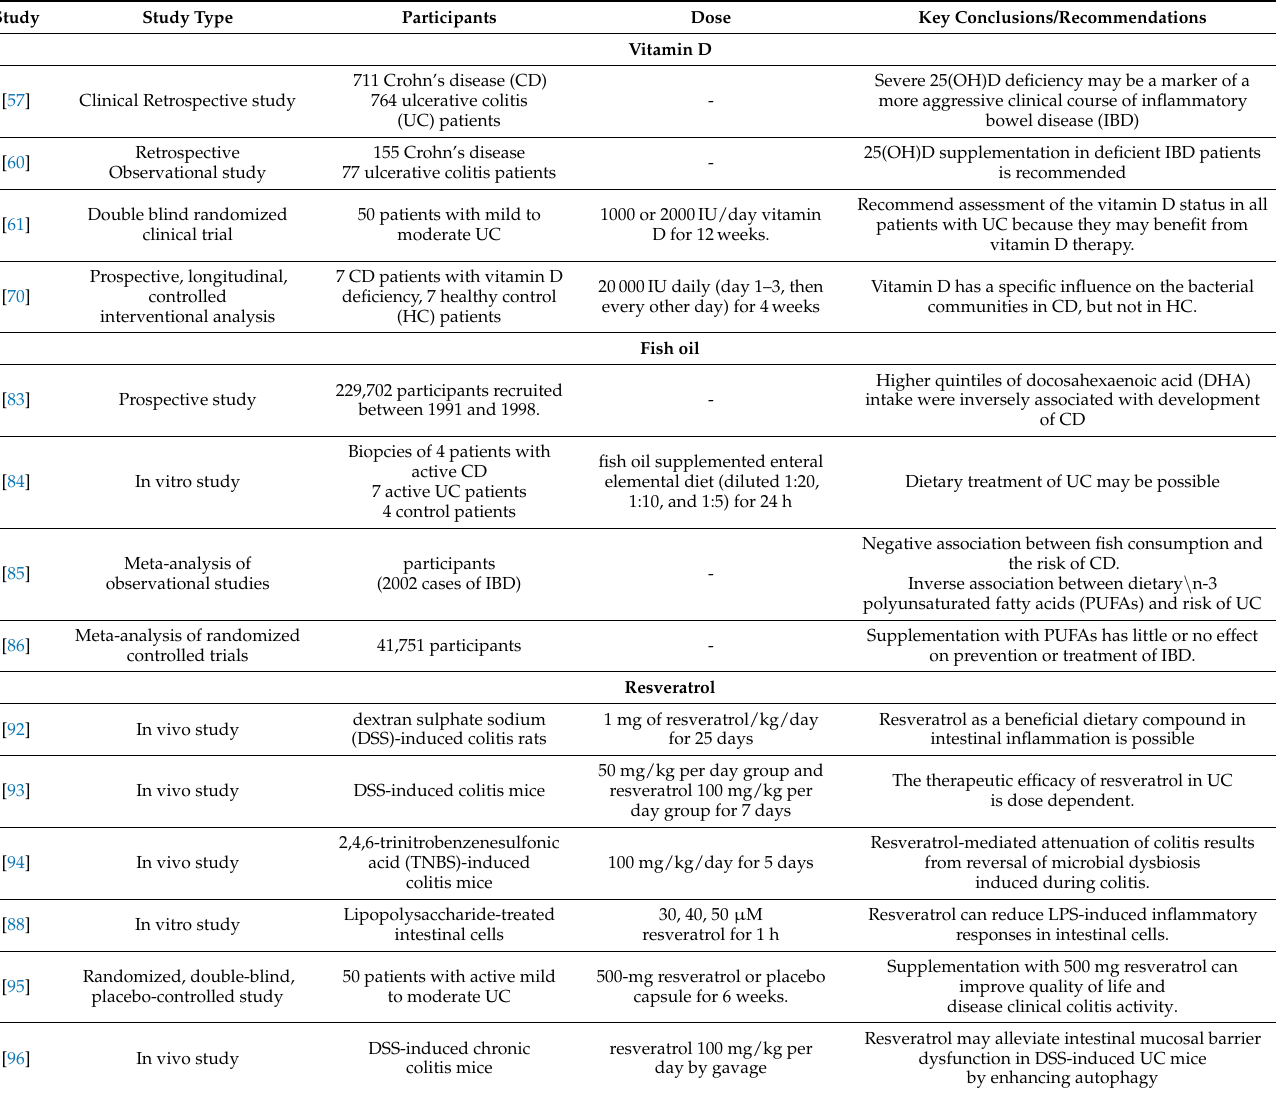
Table 1. Summary of Key Vitamin D, Fish Oil, and Resveratrol